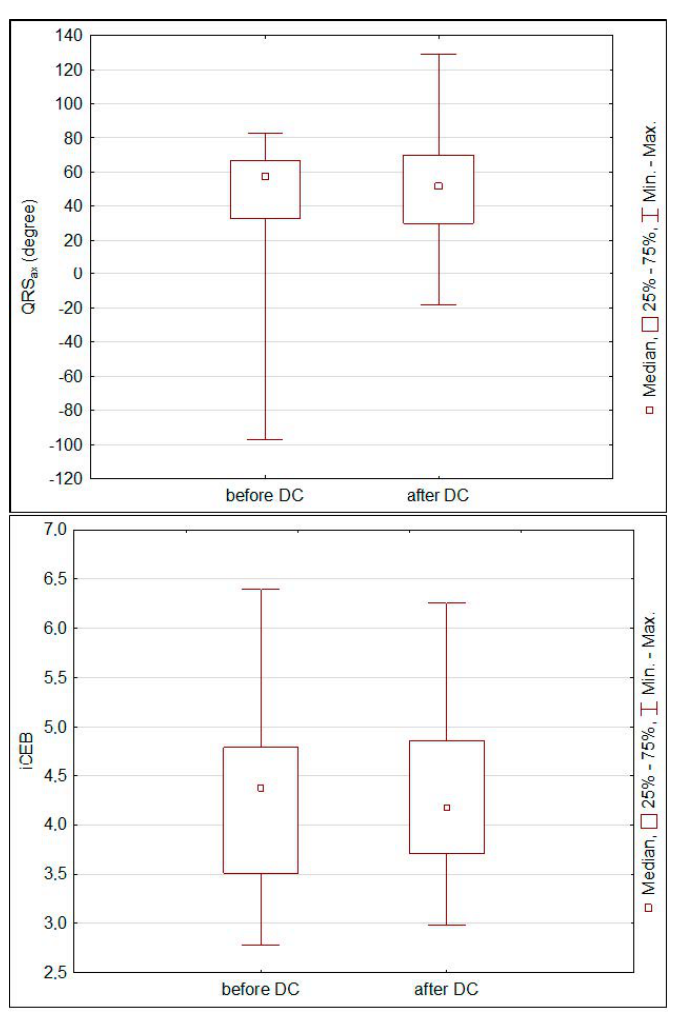
Figure 3. Changes in spatial QRS axis (QRS ax ) and the index of cardio-electrophysiological balance (iCEB) before and after decompressive craniectomy (DC) (Wilcoxon test). Table 1. A multiple regression analysis describing the dependence between the index of cardiac-electrophysiological balance (iCEB) and parameters selected on Pearson’s correlations in whole studied